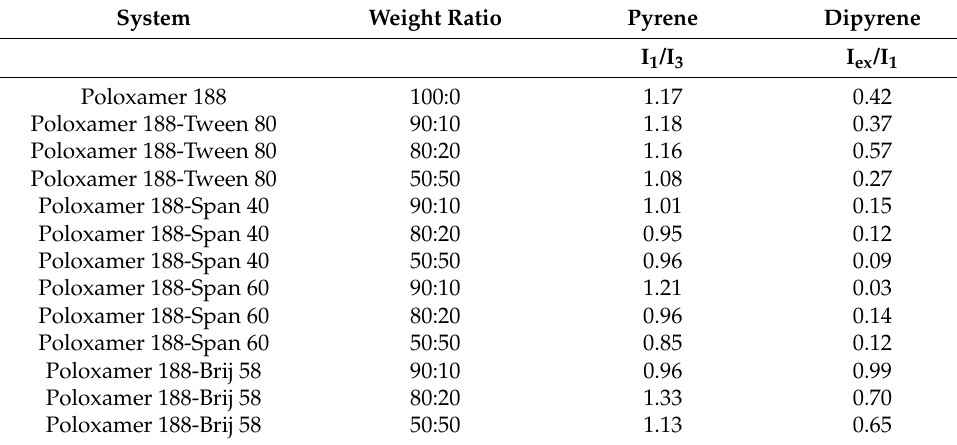
Table 2. I 1 /I 3 and I ex /I 1 values of the prepared hybrid block copolymer-surfactant systems at a fixed temperature of 25 ◦ C.